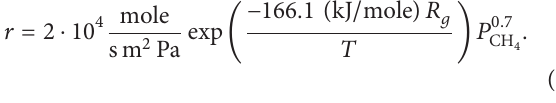
Figure 2: Startup curve for a half-cell stack at 𝑇 = 600 ∘ C, 𝑃 = 59 kPa, 𝑃 = 4kPa, and 𝑃 20 kPa, 𝑃 H 2 O H 2